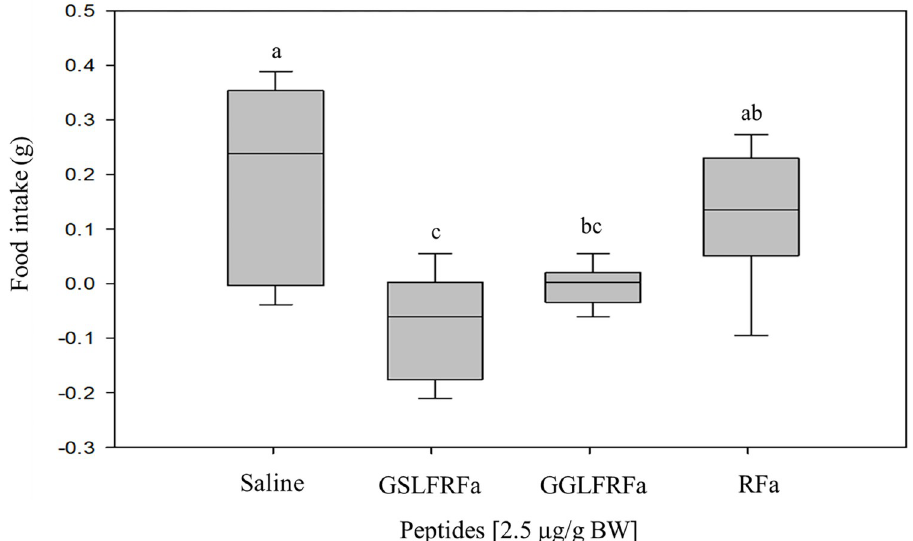
Fig 9. Effect of Hdh-LFRFa peptides on abalone food intake. Abalone were injected with GSLFRFa, GGLFRFa, RFa (2.5 μ g/g BW), or the same volume of mollusk saline. Feeding assays were performed 16 h after injection. Data are presented as mean ± SEM (n = 8). Different letters indicate statistically significant differences (p < 0.05).